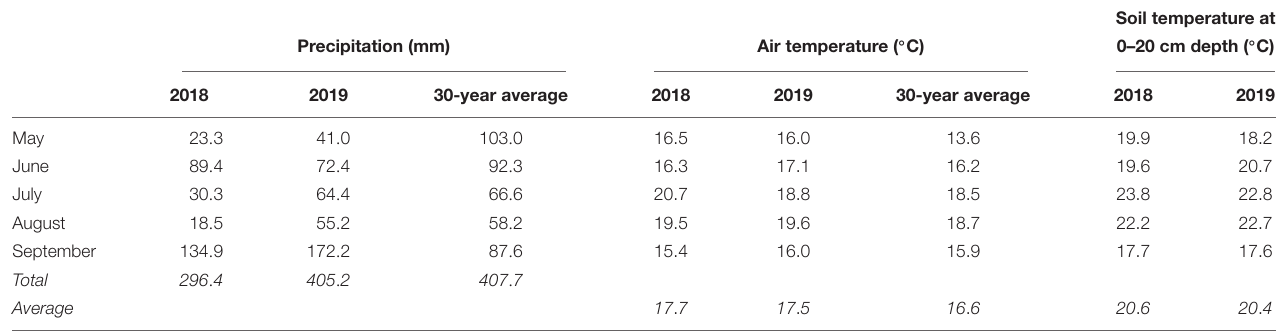
TABLE 2 | Monthly total precipitations and mean monthly air and soil temperatures at Agassiz – Rosedale, BC, in 2018 and 2019 in comparison with the 30-year (1981–2010) average.